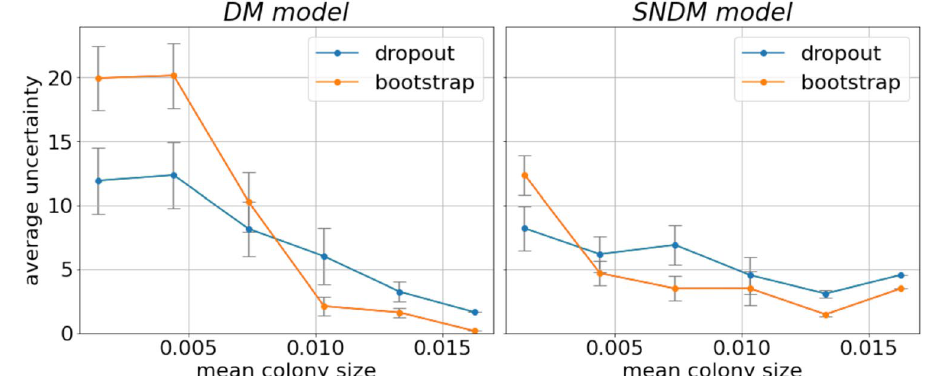
Figure 5. Dependence of the counting uncertainty on mean colony size calculated for the test subset within both models. Uncertainty values are averaged on intervals of mean colonies